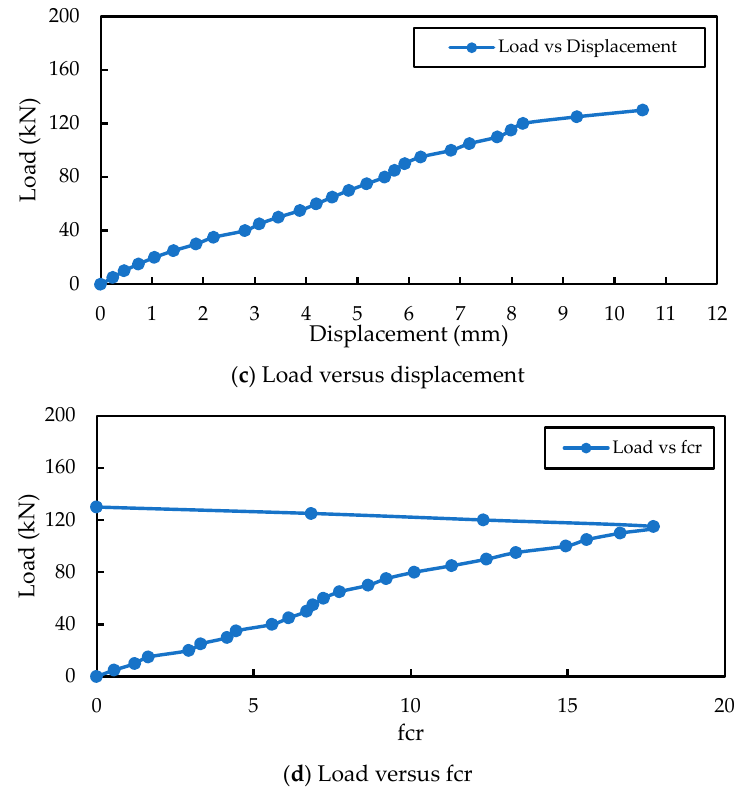
Figure 11. Graphical representation of ( a ) stress vs. strain, ( b ) fcr vs. strain, ( c ) load vs. displacement, and ( d ) load versus fcr behaviour of hybrid brass–carbon fibre-added fresh mortar layer cast on an existing concrete beam of length 1.5 m.